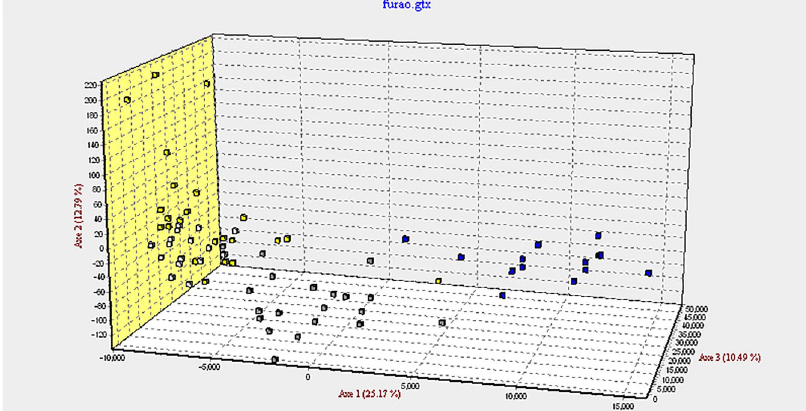
Figure 7. Three-dimensional scatter plots for the individuals of the four groups based on the factor correspondence analysis (FCA). Each axis represents one principal factor: White block: WLA-VM; Yellow block: WLA-B; Gray block: WLB-B; Blue block: RIR-B.